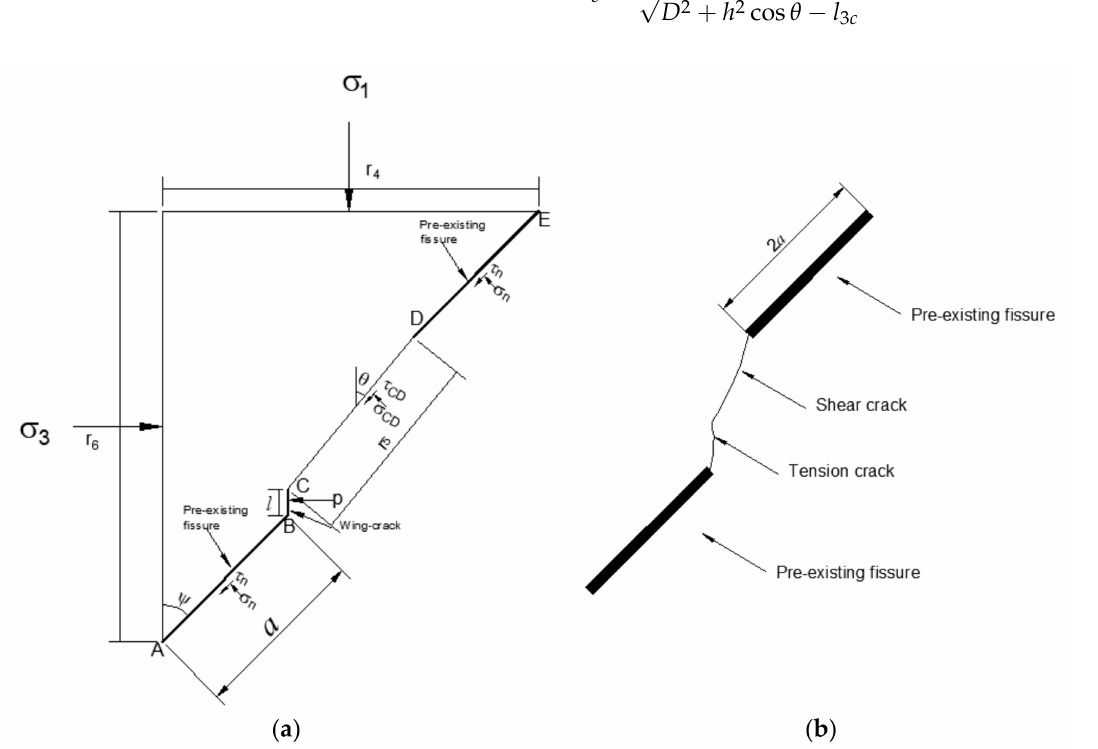
Figure 14. Characteristics of crag bridge shear failure (wing crack-shear crack failure mode). ( a ) Stress analysis of crag bridge; ( b ) failure characteristics of crag